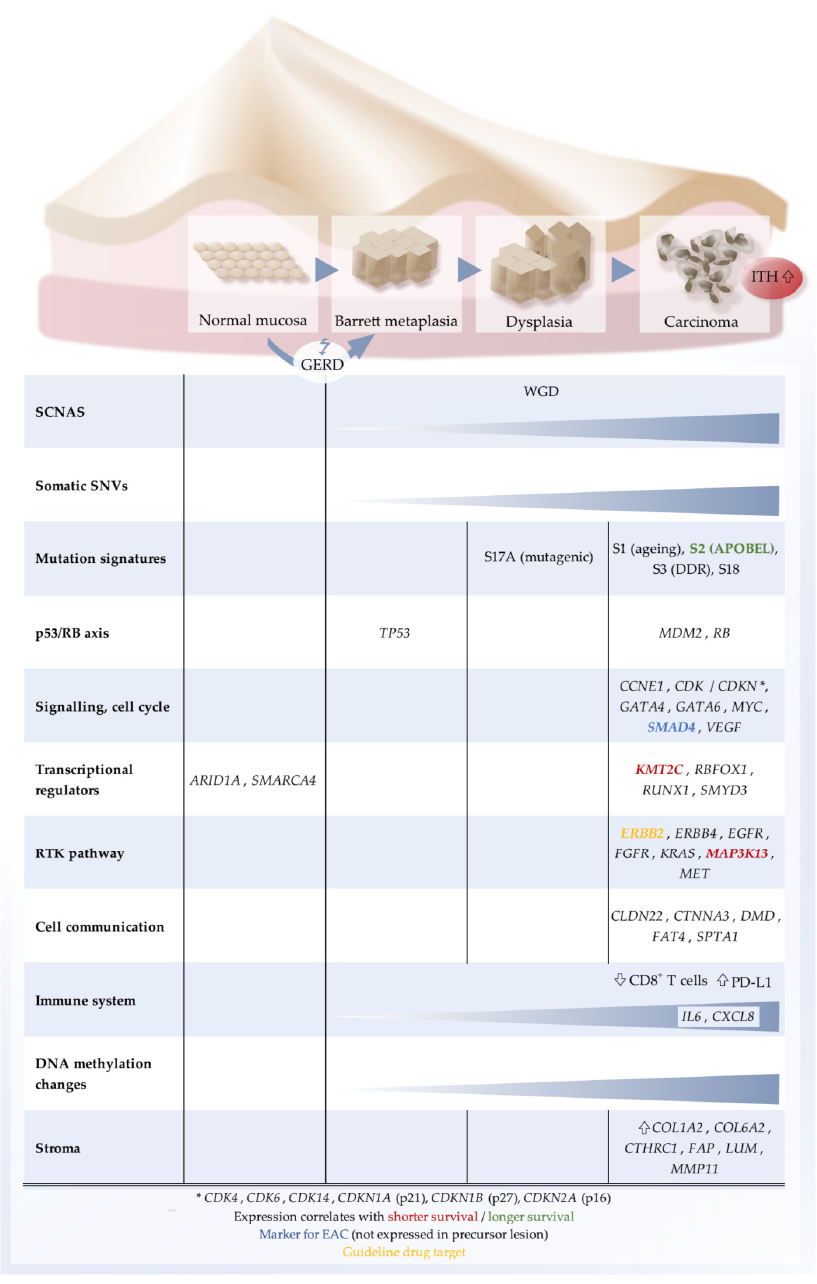
Figure 1. Schematic representation of characteristic molecular features of EAC. Top, sequence of histological states towards EAC. Bottom, list of molecular categories and key genes that are typically altered. GERD, gastro-esophageal reflux disease; ITH, intratumoral heterogeneity; RTK, receptor tyrosine kinase; SCNA, somatic genome copy number alteration; SNV: single-nucleotide variant; WGD, whole genome doubling.